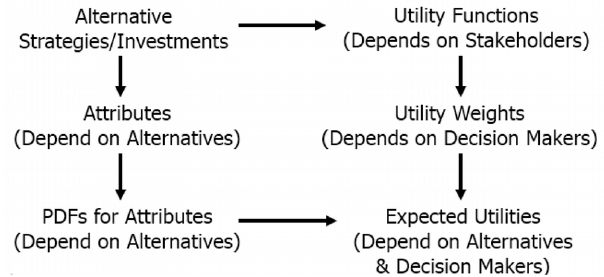
Figure 3. Utility model